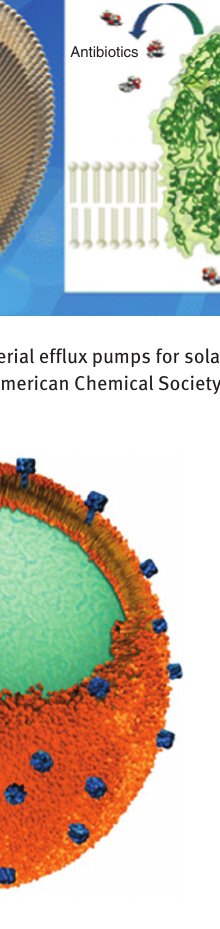
Figure 7 The illustration (reproduced from http://www.technolo- gyreview.com/news/513461/nanoparticle-disguised-as-a-blood- cell-fights-bacterial-infection/) shows how the nanosponge’s solid polymer core (green) is surrounded by a red blood cell membrane (red). The blue structures represent absorbed